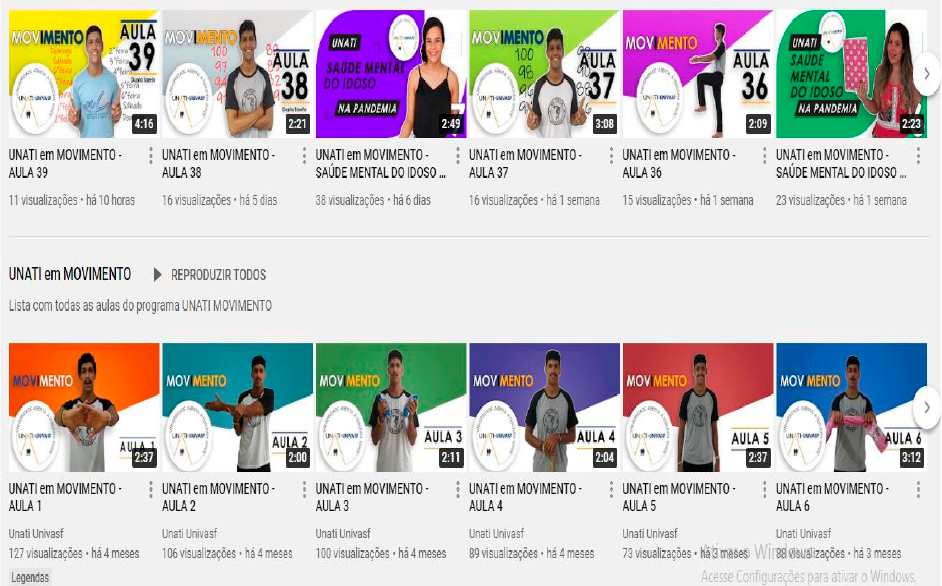
Figure 2. Images of the videos of the “U3A in Motion” program posted on the YouTube platform (2020–2021).